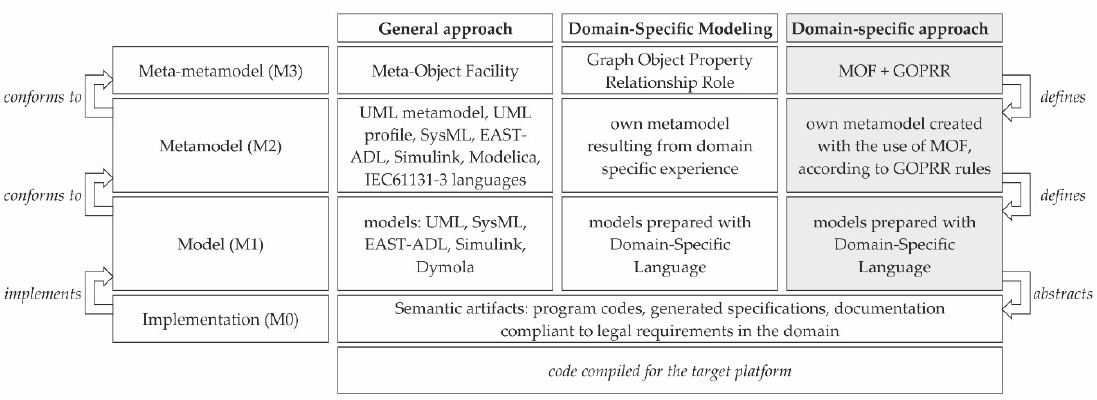
Figure 6. Four-layer metamodeling approach. Meta-metamodel (M3) defines abstractions